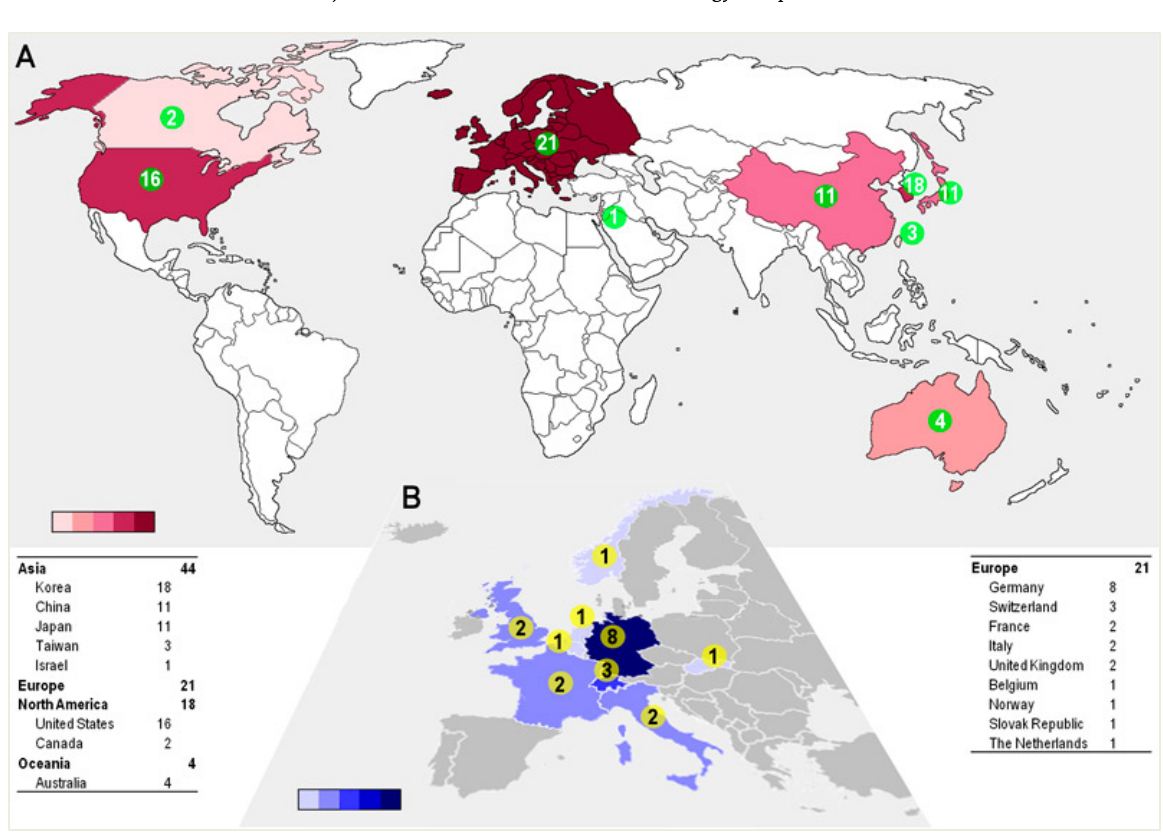
Figure 3: Where is xenotransplantation research taking place? Number of research groups per country working in xenotransplantation. Data were extracted from the abstracts presented at the International Pancreas and Islet Transplantation Association-IXA 2015 joint conference, as according to criteria: (i) any type of research involving a xenotransplantation system; (ii) the number of different research groups per country. (A) Global view considering the European continent instead of individual countries. (B) Close up of Europe indicating the contributions by country. Colour gradients either in red or blue represent